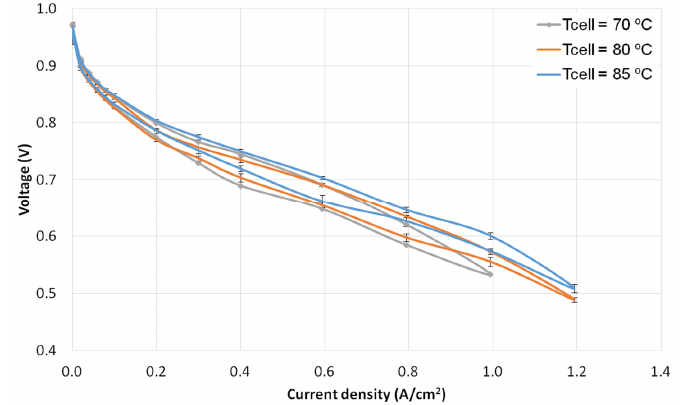
Figure 4. Polarization curve for temperature tests. Forward curve (increasing current) at the bottom; backward curve (decreasing current) at the top. Error bars corresponding to the three repetitions are included for each measurement point.